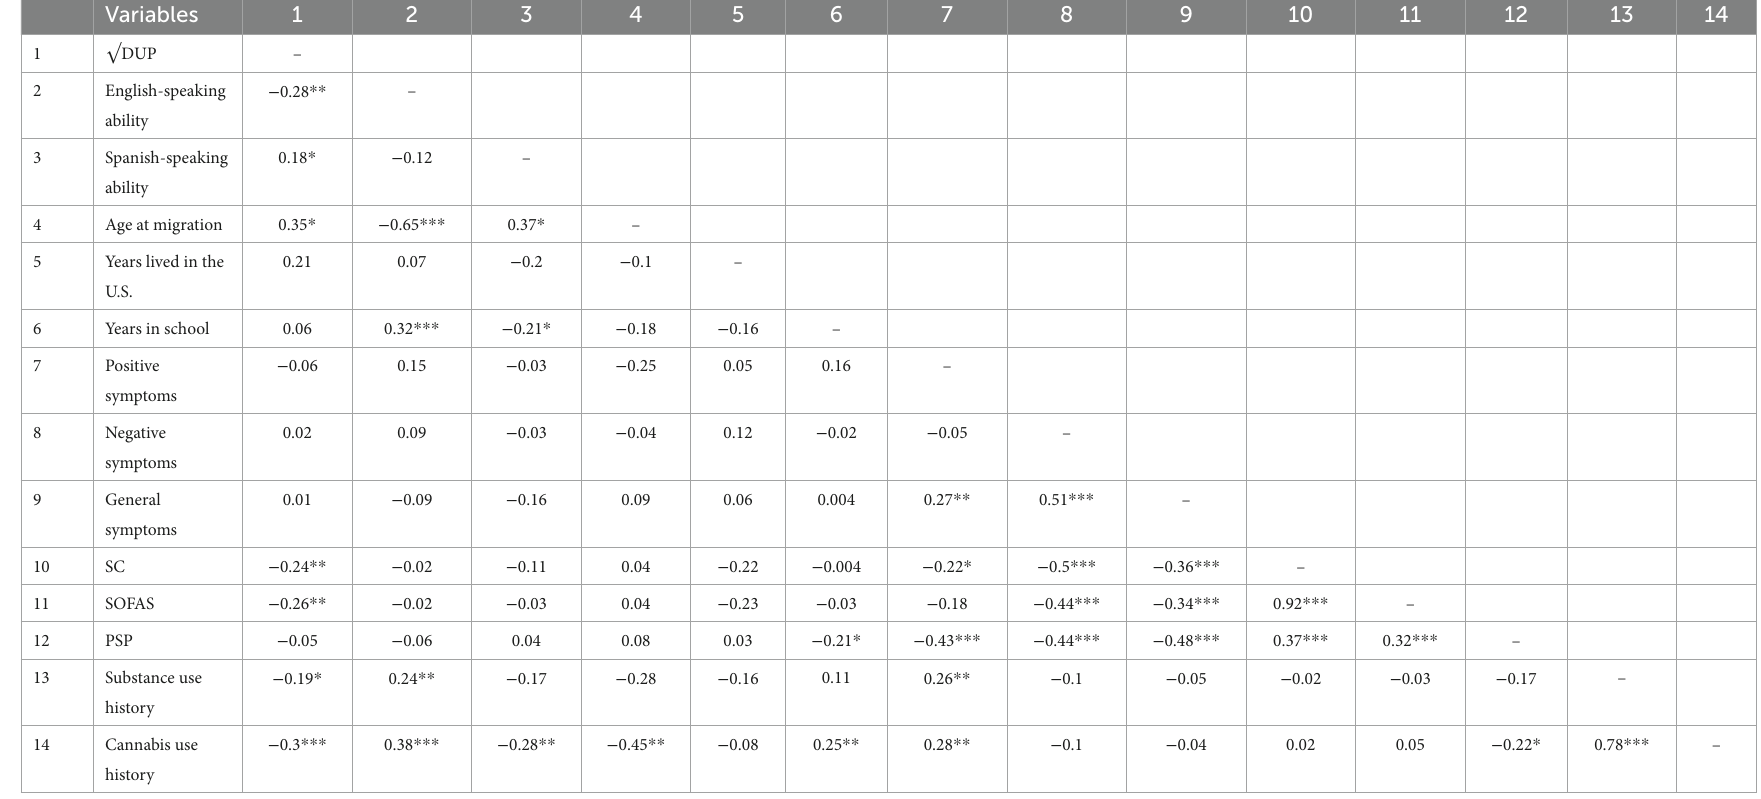
TABLE 1 Correlations between the DUP and sociodemographic and clinical and social functioning variables.